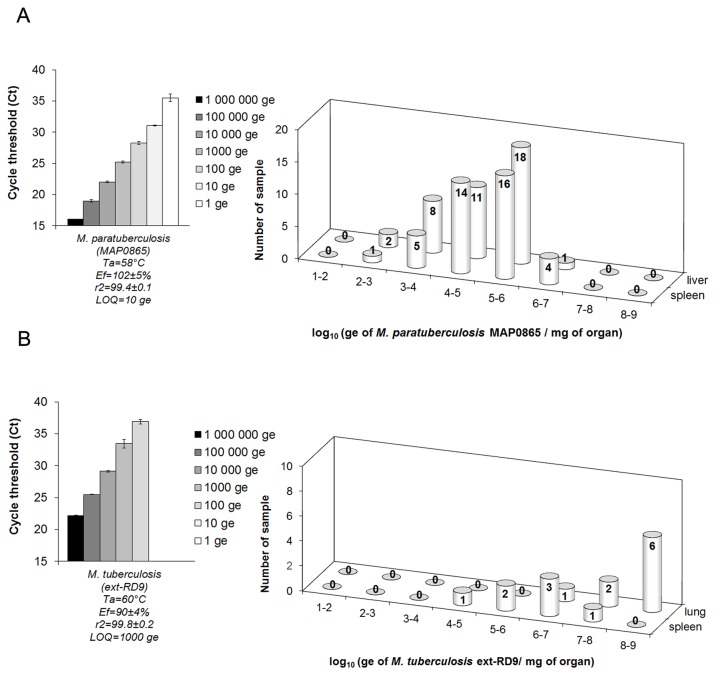

in
vitro limit of quantification (on the left) estimated by reproducible TaqMan real-time PCR amplifications of MAP0865 (n=63) and ext-RD9 (n=21) for MAP K-10 (A) and M. tuberculosis H37Rv quantification (B), and limits of quantification in tissues (on the right) estimated by distribution analyses of sample number according to MAP K-10 (A) and M. tuberculosis H37Rv (B) densities, estimated by TaqMan real-time PCR targeting MAP0865 (n=40 spleen, n=40 liver) or ext-RD9 (n=7 spleen, n=9 lung), respectively.All these accurate real-time PCR results are observed for a host DNA amount < 3 µg in a final volume of 25 µl, and DNA purity at 260/280 nm ratio = 1.89±0.08.